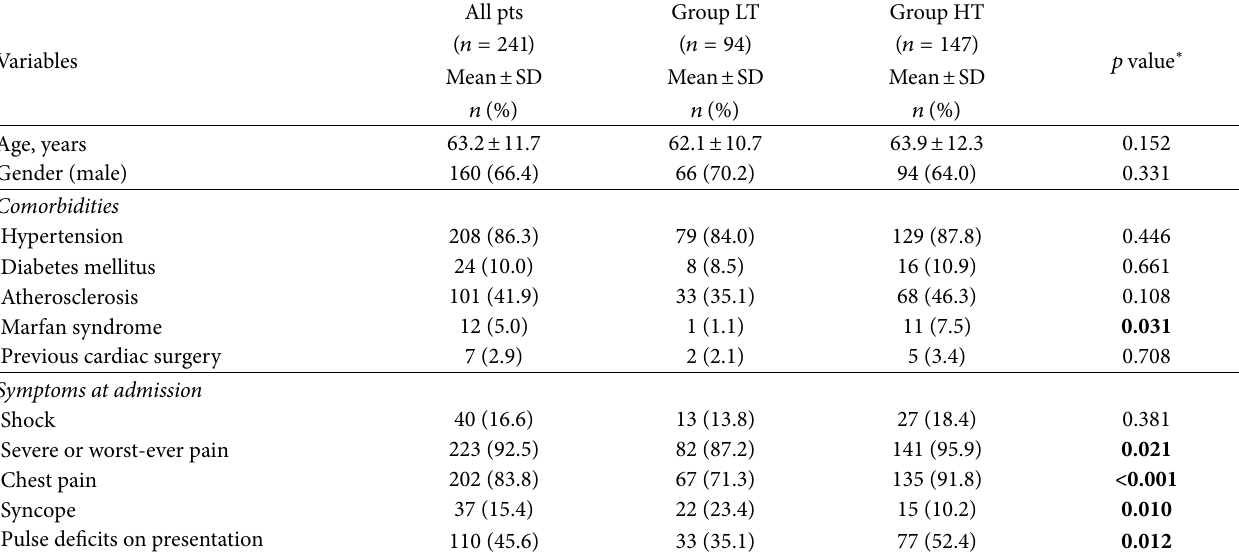
Table 1: Demographics and preoperative baseline characteristics.